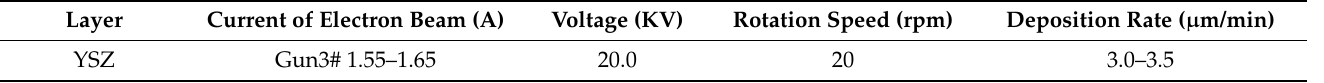
Table 1. Preparation parameters of